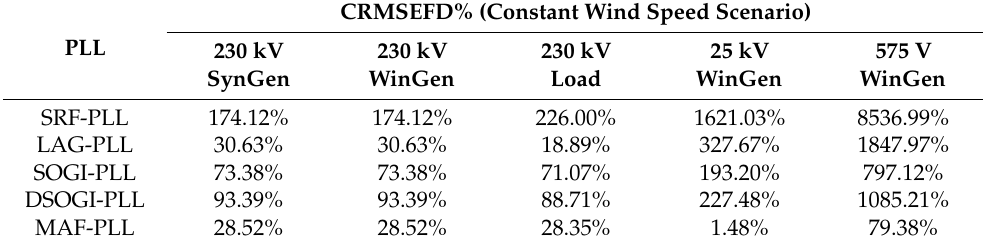
Table 5. Cumulative RMSEFD values for the PLLs located at the different buses in the constant wind speed